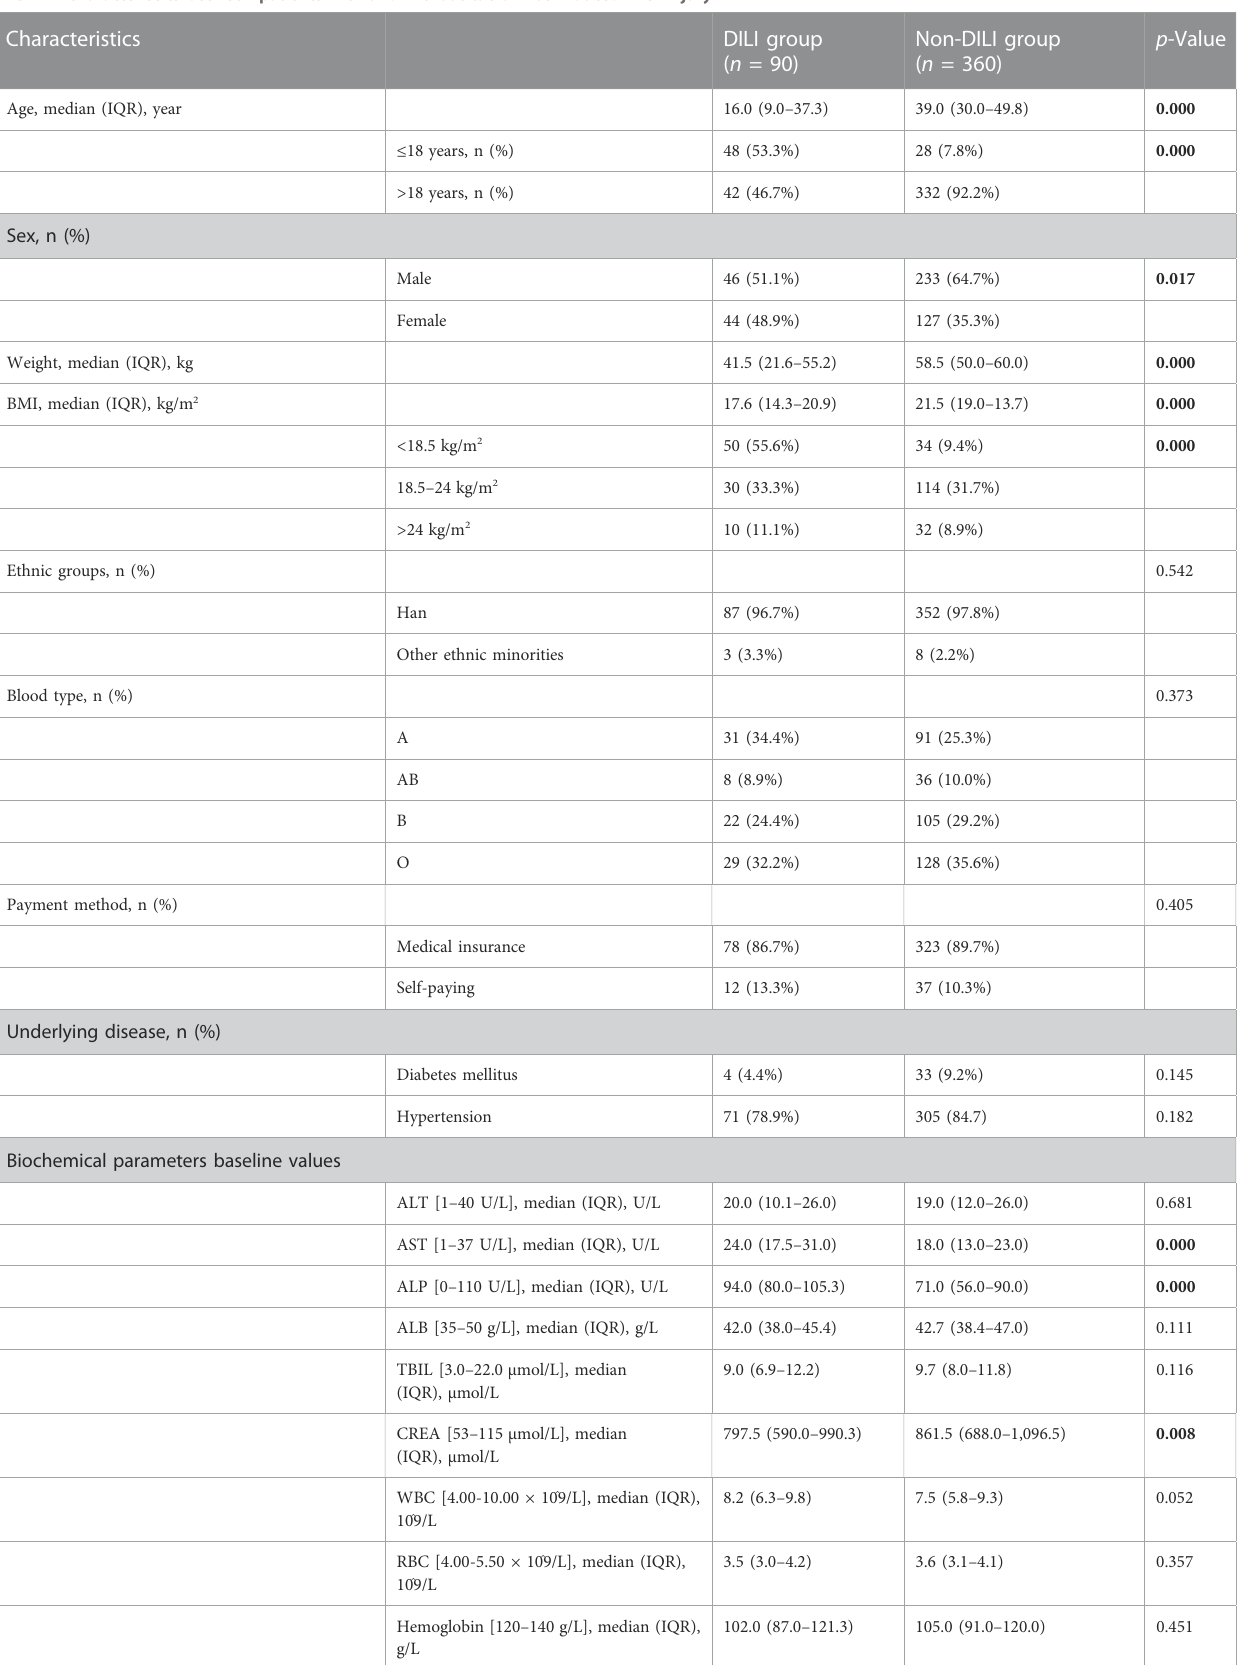
TABLE 2 Characteristics between patients with and without tacrolimus-induced liver injury.